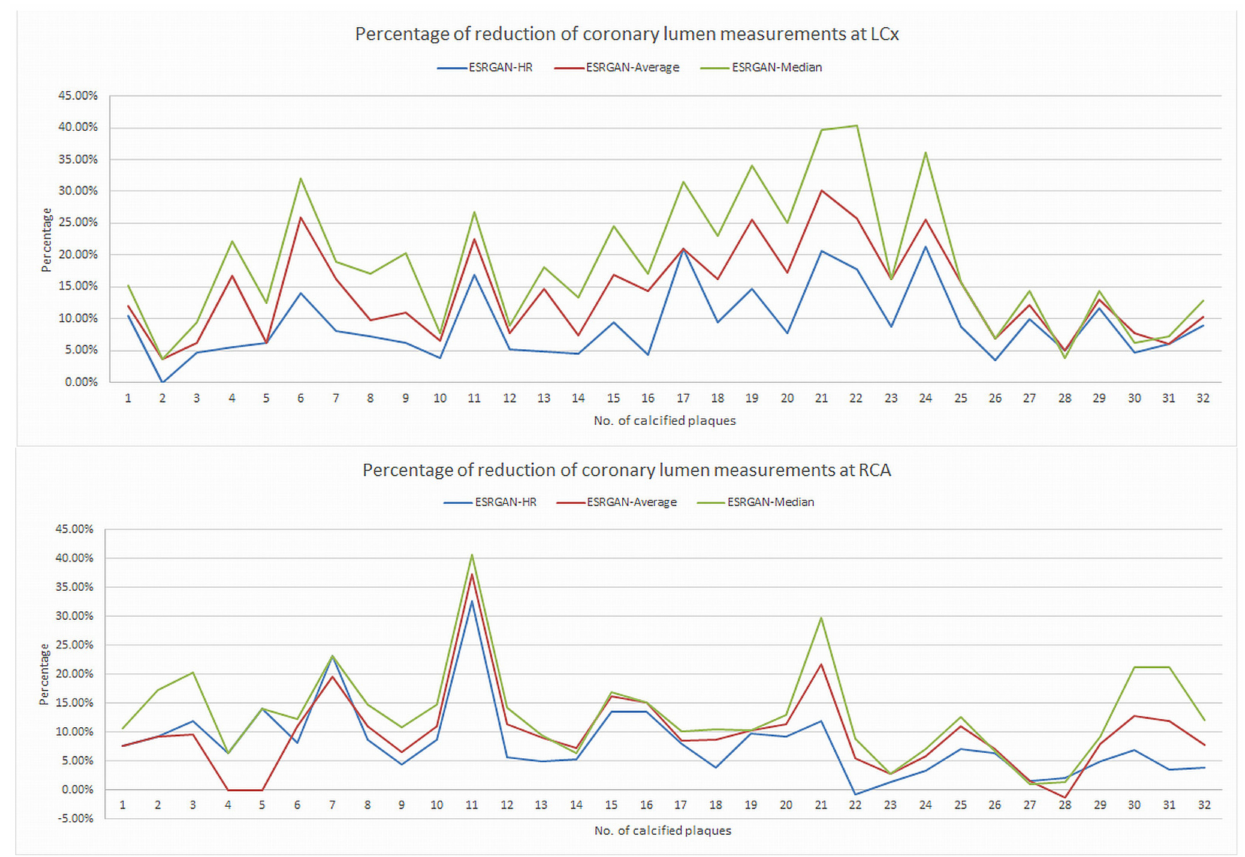
Figure 2. Graphs showing the comparison of measurement differences in coronary lumen stenosis between ESRGAN-processed and original CCTA images in terms of percentage reduction at LAD, LCx and RCA. ESRGAN-Median processed images lead to the highest reduction than the ESRGAN-HR and Average. CCTA-coronary computed tomography angiography; ESRGAN-enhanced super- resolution generative adversarial network; HR-high-resolution; LAD-left anterior descending; LCx- left circumflex; No.-number; RCA-right coronary